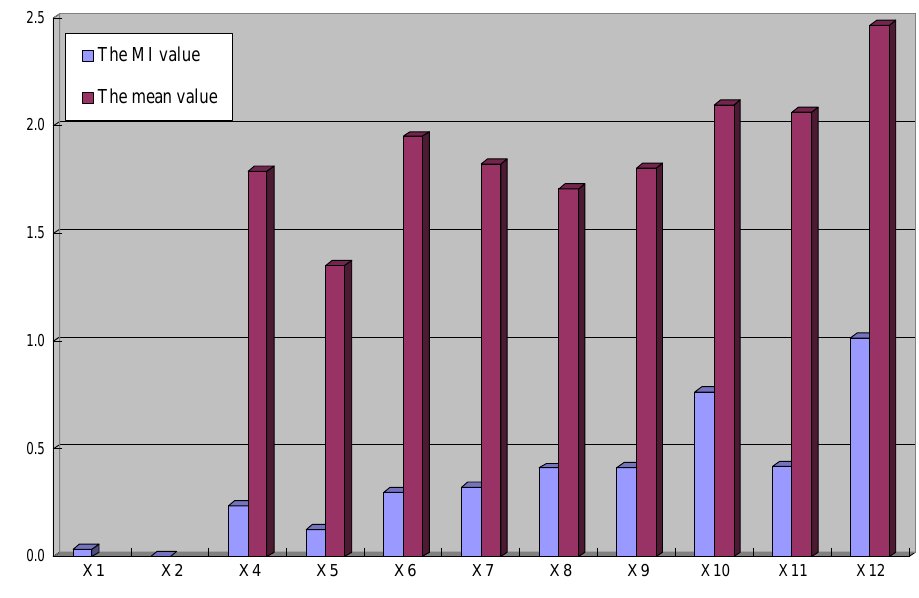
Figure 6. The MI and mean values of each deciding factor for S-students.